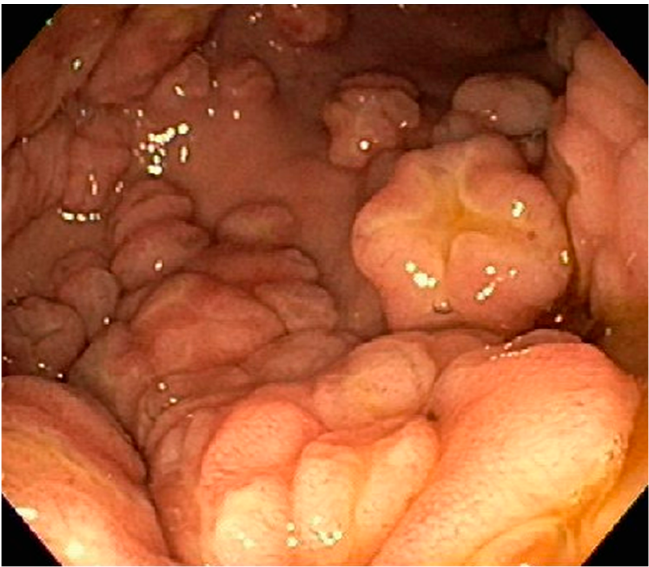
Figure 15. Innumerable polypoid appearing gastric lesions throughout the stomach.